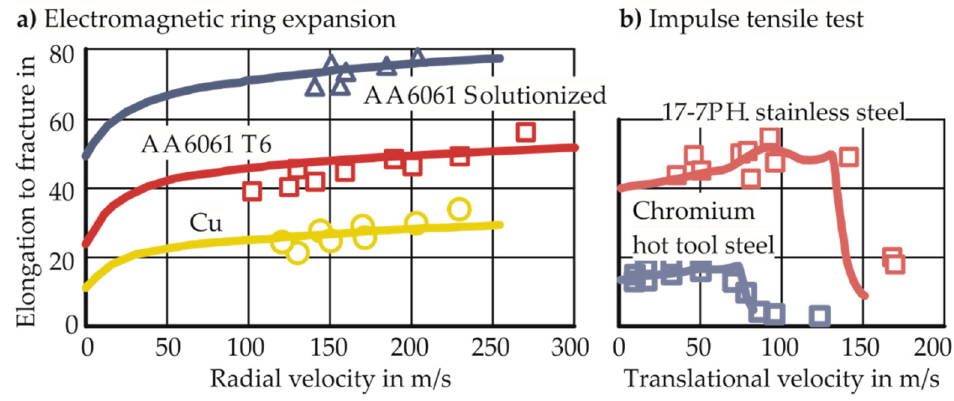
Figure 4. Lines show the simulation results of Hu and Daehn [16]. Points show the experimental results of ( a ) Altynova et al. [17] and ( b ) Wood [9].